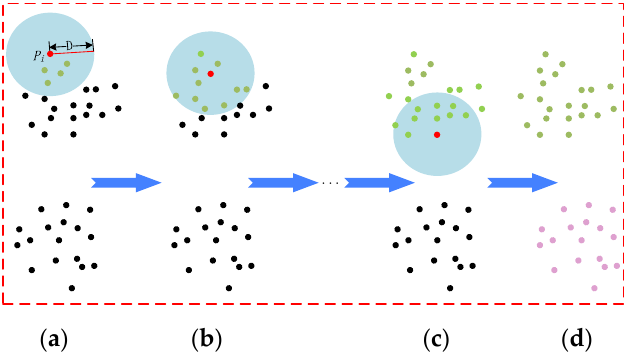
Figure 7. Diagrammatic sketch of Euclidean clustering. ( a – c ) The points before Euclidean cluster- ing is complete; ( d ) The points after Euclidean clustering is complete. 2.3. Road Markings Recogni-